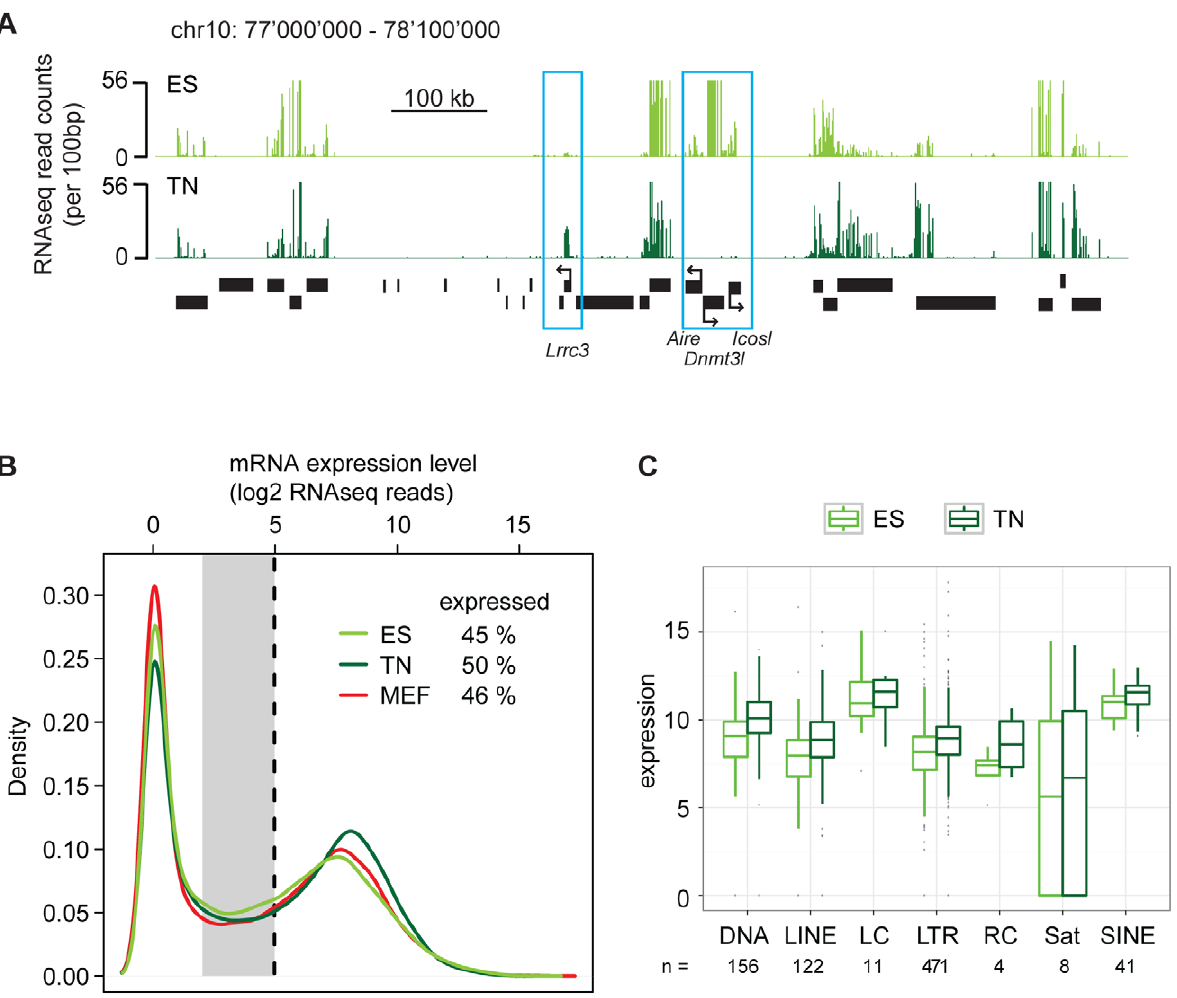
Figure 4. Promiscuous low-level expression is not a distinctive feature of the pluripotent state. (A) Representative region illustrating RNAseq data in ES cells and neurons (TN). Blue boxes indicate genes that either increase ( Lrrc3 , a neuron specific ion channel) or decrease ( Aire , Dnmt3l , Icosl ; three ES cell specific genes) expression during differentiation, while the other genes remain constant. (B) Density distribution of transcript abundance (measured as read counts) for all RefSeq transcripts in ES cells (green line), derived neurons (dark green line) and mouse embryonic fibroblasts (red line). Numbers indicate percentage of expressed genes in each cell type based on a threshold of log2(read count)=5 (black dotted line). The gray area between 2 and 5 indicates the zone of low-level expression. (C) Boxplot representation of expression levels of prominent repeat classes in ES cells and neurons (TN). Numbers below indicate how many repeat elements are included in each repeat class.